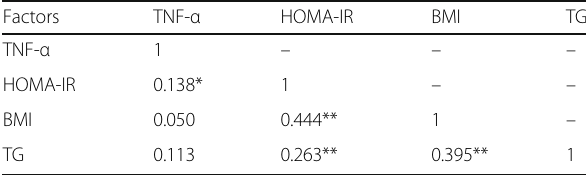
Table 3 Pearson Correlation Coefficients between TNF- α